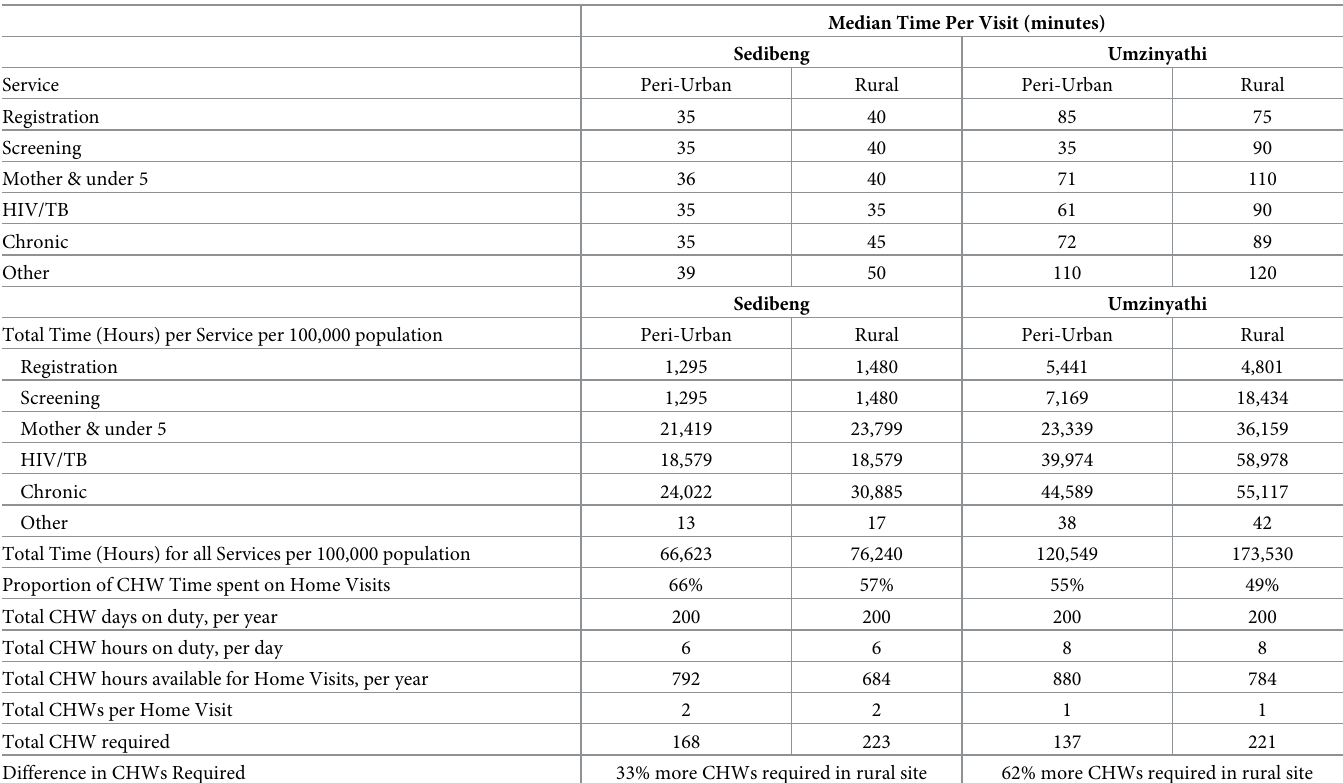
Table 8. CHWS required for 100,000 population per type of site in Sedibeng.